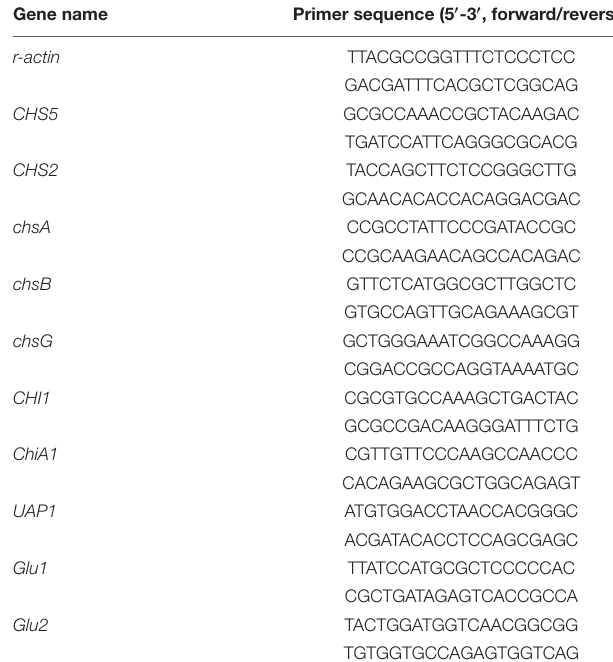
TABLE 1 | Primer pair sequences designed for validation of differentially expressed genes in control and 1/2MIC CA treatment of G. citri-aurantii using Real-time Fluorescence Quantitative PCR